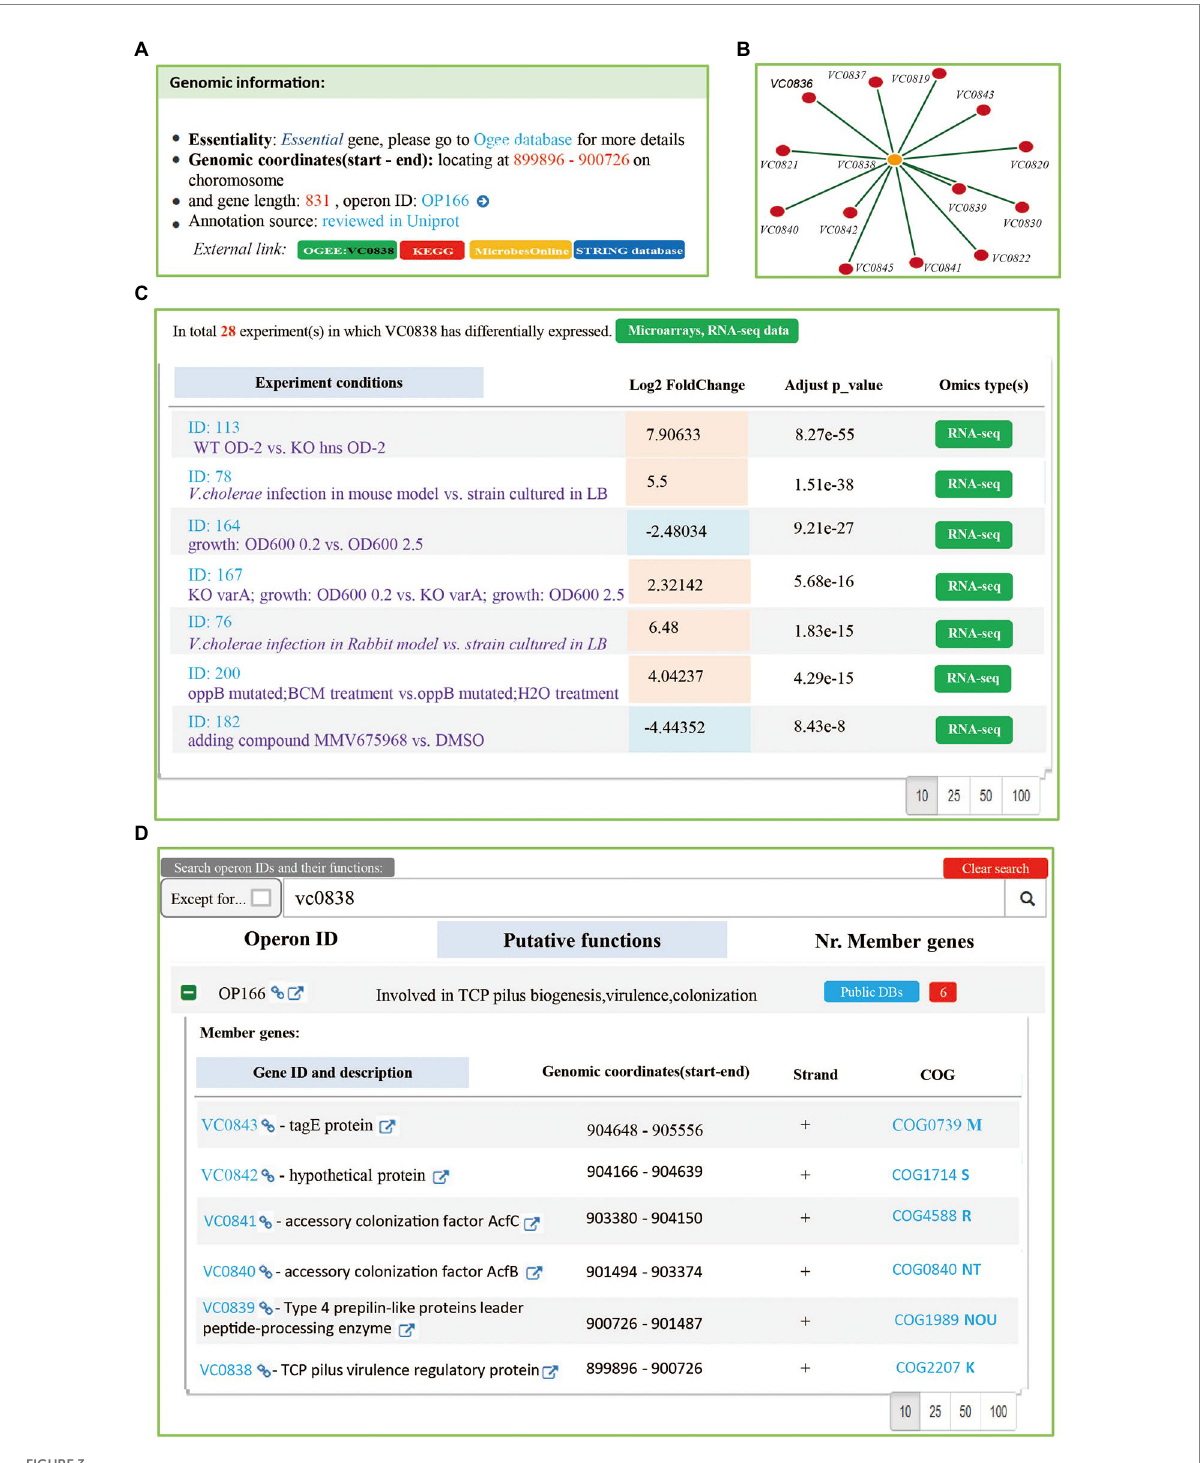
FIGURE 3 The “Genes and “Operons” page. (A) A summary of Vibrio cholerae gene VC0838. The information of gene annotation including gene ID, description, gene location, gene orientation, gene length, and gene essentiality was provided. (B) The gene co-expression network. Mr.Vc v2 filtered and obtained gene co-expression entries, according to the calculated pearson’s correlation coefficients (>0.8), Spearman’s correlation coefficients (>0.8), and p -value (<0.05) between genes. There are 14 genes associated with gene VC0838 in our database. (C) A list of experiments in which gene VC0838 is differentially expressed in. A total of 28 experiments were collected, including Microarray and RNA-seq experiments. (D) The operon information. Searching genes to match to corresponding operon page, which listed putative function and member genes information of